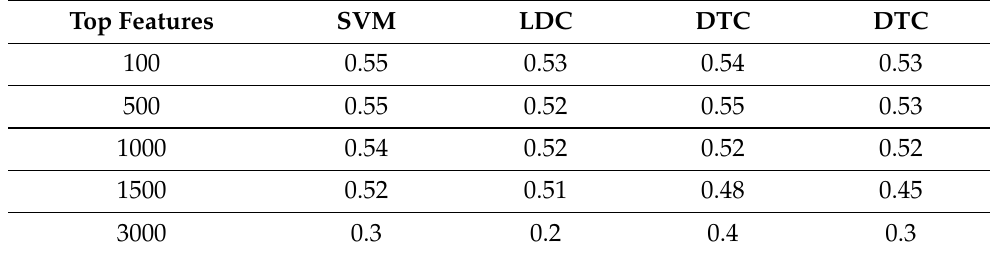
Table 3. Accuracy Comparison of High Number of Features.